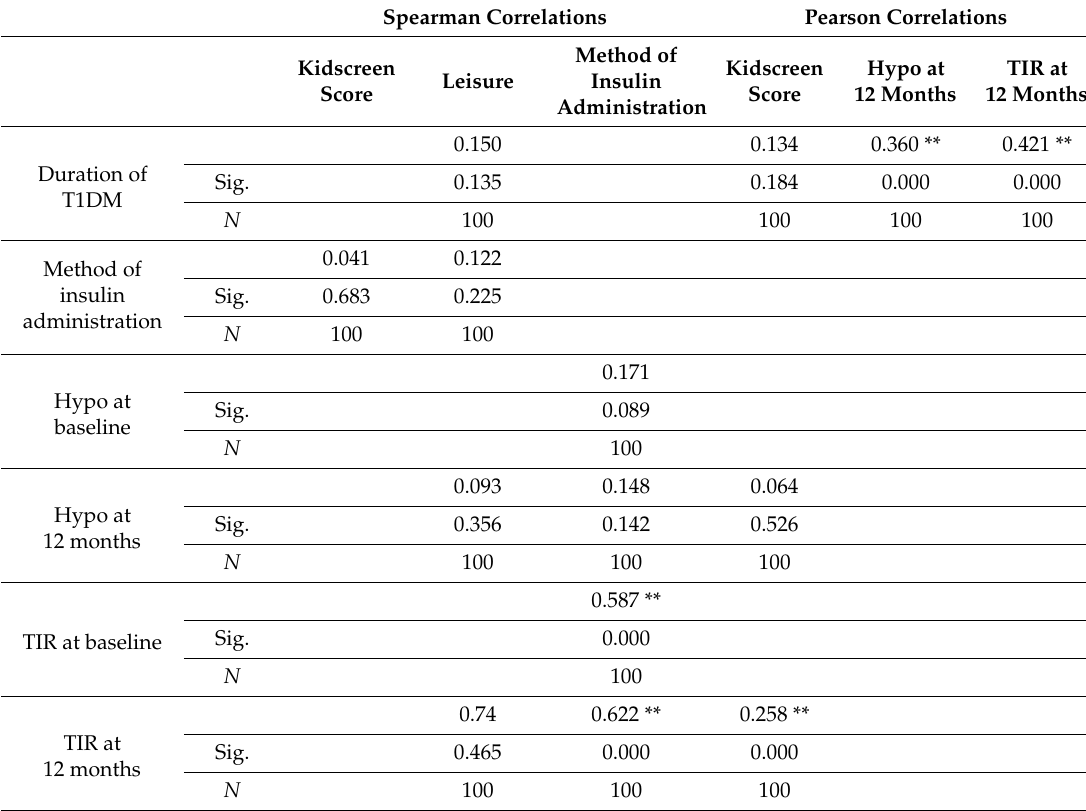
Table 10. Correlations among clinical characteristics and Kidscreen total